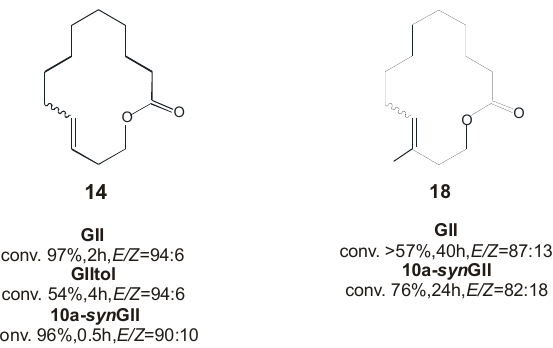
Figure 9. Macrocyclic RCM products 14 and 18 .